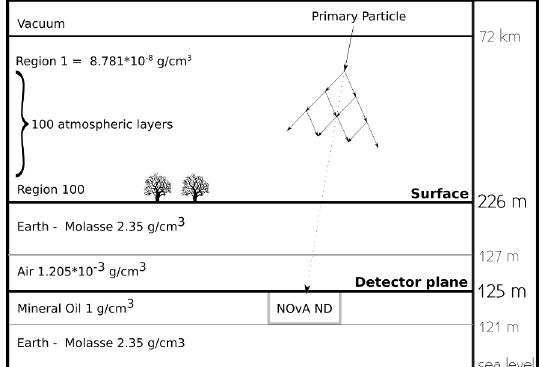
Figure 1: Geometry implemented to study the multi-muon seasonal variation observed by NOvA ND.